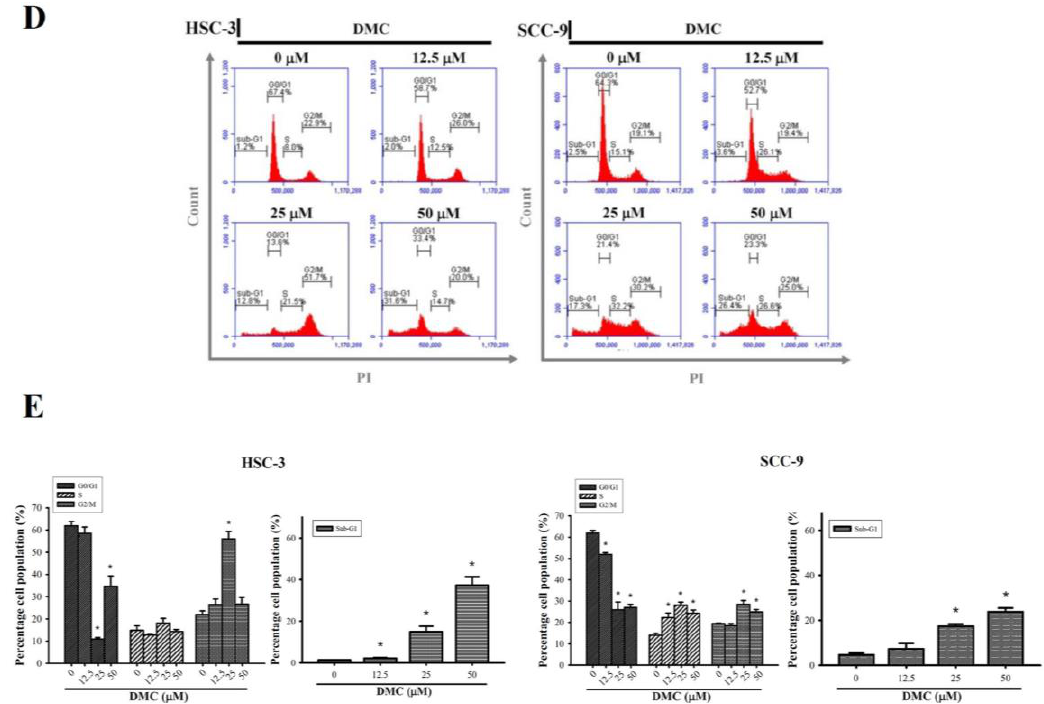
Figure 1. Demethoxycurcumin (DMC) inhibits the proliferation and colony formation via inducing G 2 /M phase arrest in oral squamous cell carcinoma (OSCC) cells. ( A ) The chemical structure of DMC. ( B ) Two OSCC cell lines, SCC-9 and HSC-3, and one normal gingival epithelial cell line, SG, were treated with indicated concentrations of DMC (12.5, 25, and 50 μM) or DMSO (vehicle control) for 24 h, and a thiazolyl blue tetrazolium bromide (MTT) assay was performed to determine the cell viability. * p < 0.05, compared to the DMSO-treated group. # p < 0.05, compared to the OSCC cells. ( C ) After 24 h treatment of vehicle or DMC (12.5–50 μM) with OSCC cells, the medium was changed to remove DMC, and SCC-9 and HSC-3 cells were respectively maintained in fresh medium for 18 and 7 days to determine the long-term death-inducing effects of DMC. Representative photomicrographs were shown in the left panel. Data was given semi-logarithmically as a survival fraction/DMC dose plot. ( D ) After 24 h treatment of vehicle or DMC (12.5–50 μM) with SCC-9 and HSC-3 cells, the cell-cycle phase distribution and cell death in the sub-G 1 phase were analyzed by FACS after propidium iodide (PI) staining. ( E ) Diagrams summarize cell-cycle results.